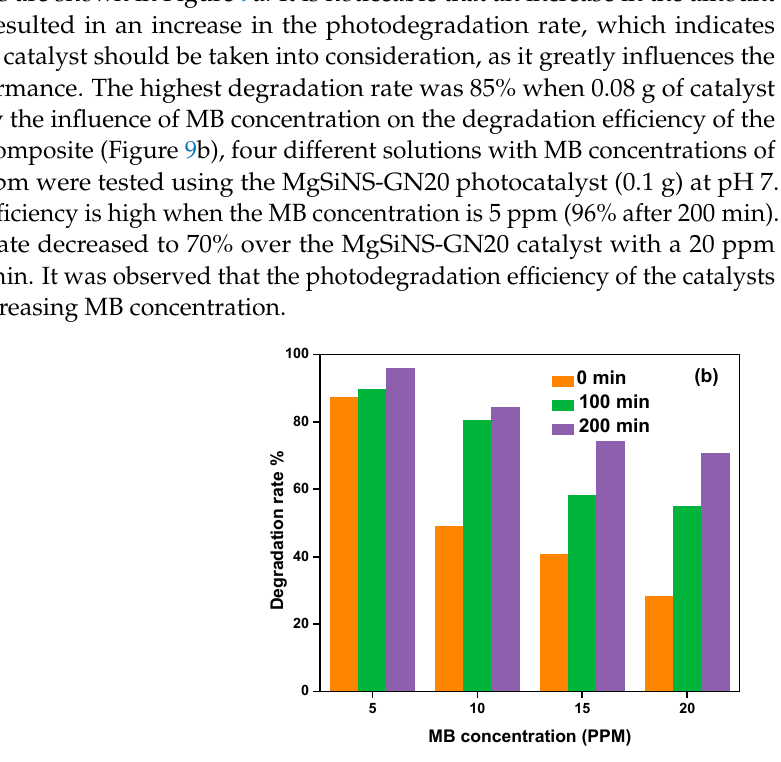
Figure 9. ( a ) Influence of amount of MgSiNS-GN20 on the MB photodegradation rate. ( b ) Influence of MB concentration on the MB degradation efficiency under visible light.